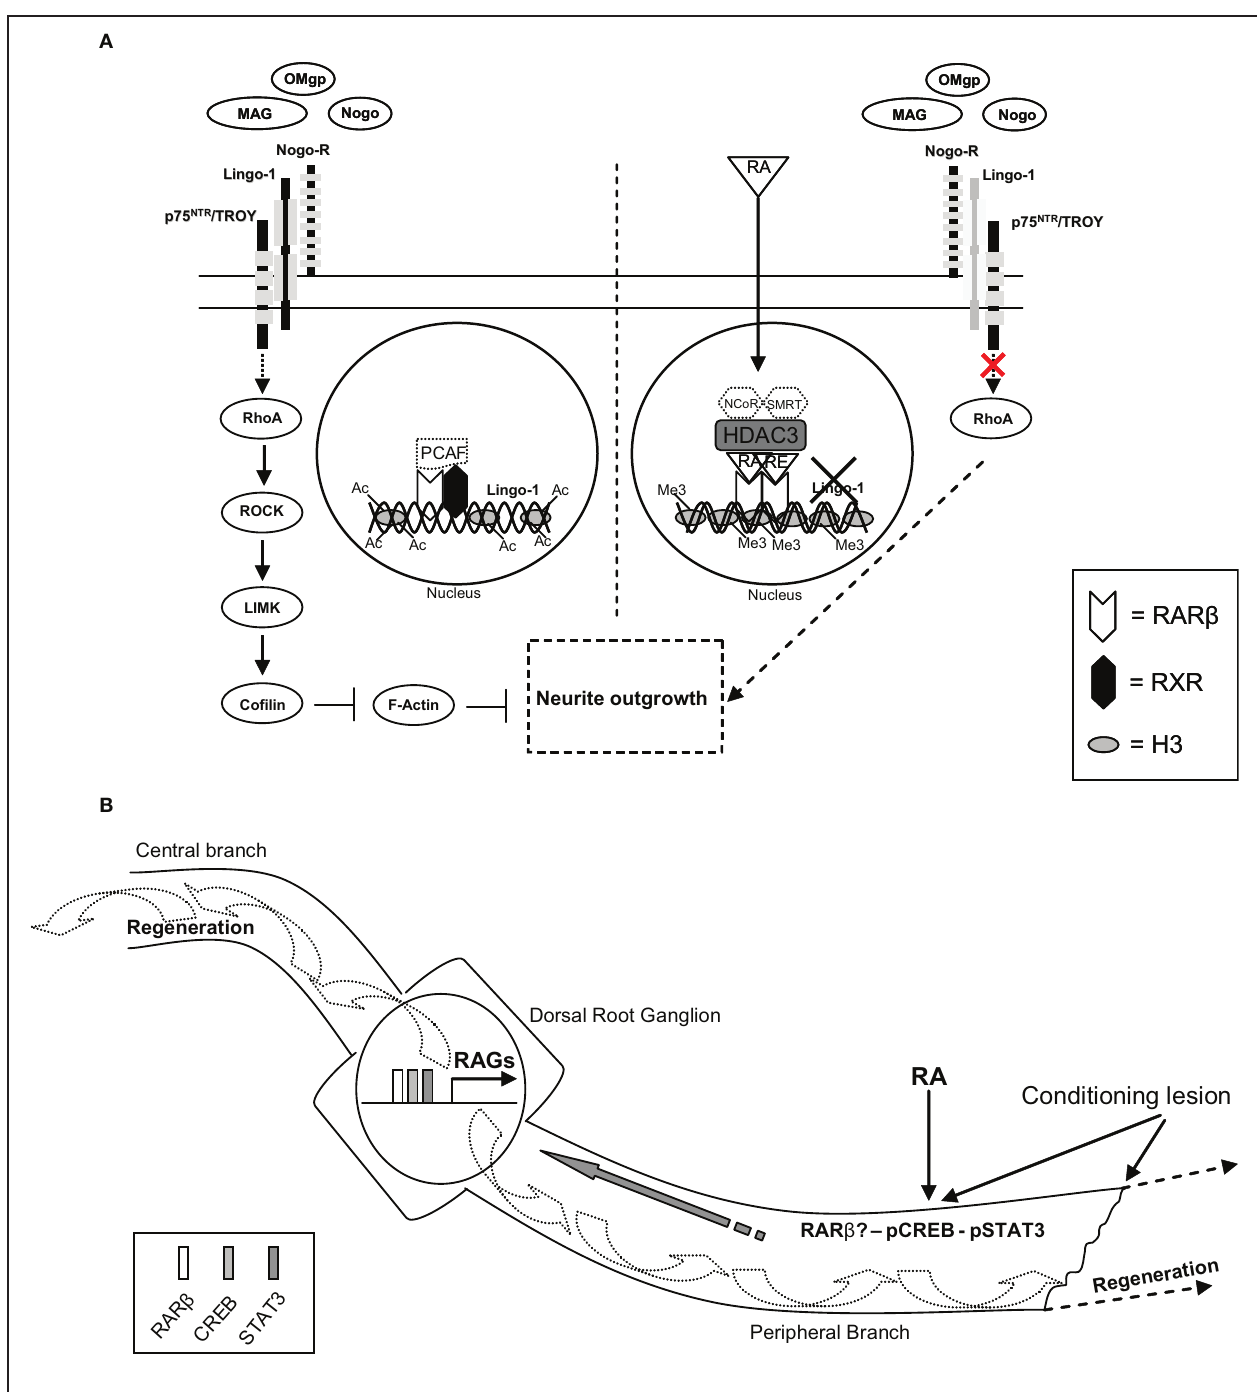
FIGURE 1 | RA-RAR β dependent direct transcriptional repression of inhibitory myelin signaling and a hypothetical schematic of RA involvement in retrograde signaling, RAGs expression, and axonal regeneration. (A) Following RA treatment HDAC3 binding to the RARE of the Lingo-1 promoter decreases acetylation of H3 lysine 9 and possibly displaces PCAF binding. Meanwhile, an increase in methylation of H3 lysine 27 is observed, coupled with strong binding of a RAR β homodimer to the RARE of the Lingo-1 promoter repressing Lingo-1 expression. This is believed to displace the equilibrium of the NogoR complex and block the activation of RhoA, thus leading to neurite outgrowth. Other possible